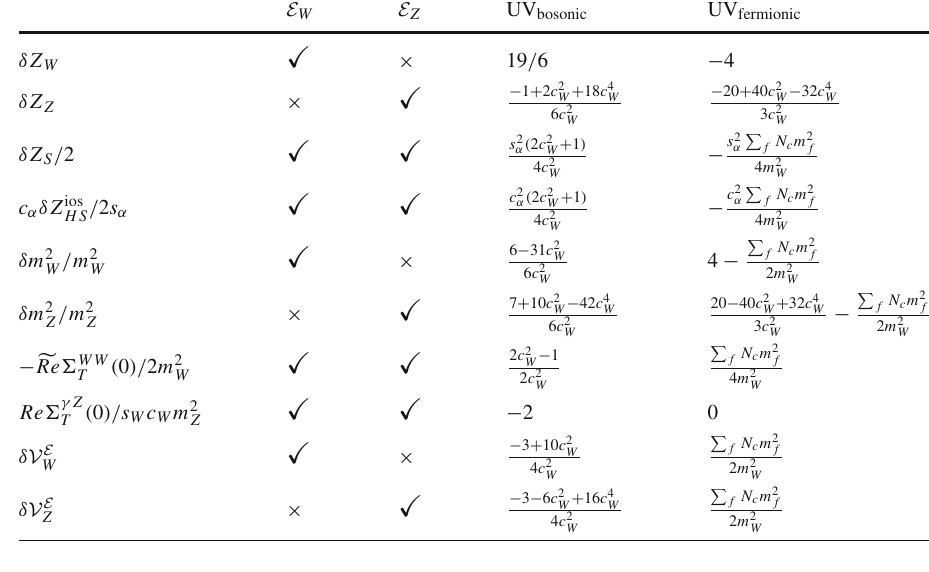
Table 1 Coefficients of the